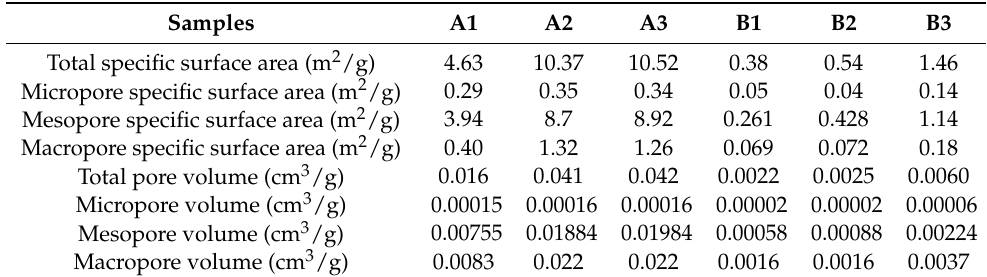
Table 2. BJH pore structural parameters of the mudstone and coal specimens with distinct granule diameters from the LT-N 2 A measurement.